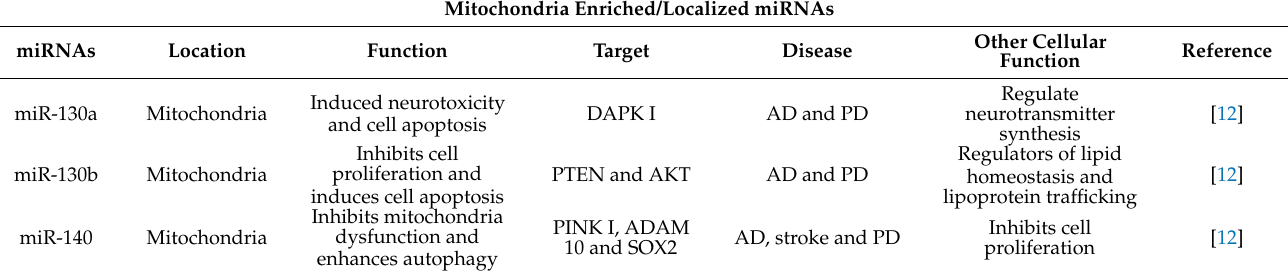
Table 1. Mitochondria localized miRNAs and mitochondria-associated miRNAs, their location and cellular function in AD and other